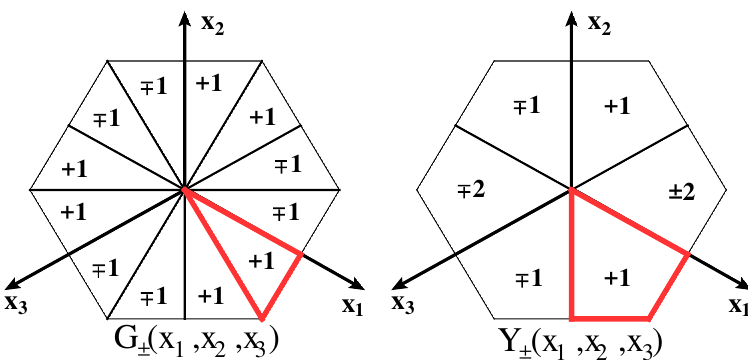
Figure 8 . The value of functions G (cid:6) and Y (cid:6) in the whole domain is de(cid:12)ned by values in the red segments. The values in other segments is obtained by turning/re(cid:13)ecting the values with respect to edges and multiplying by the factor shown within the